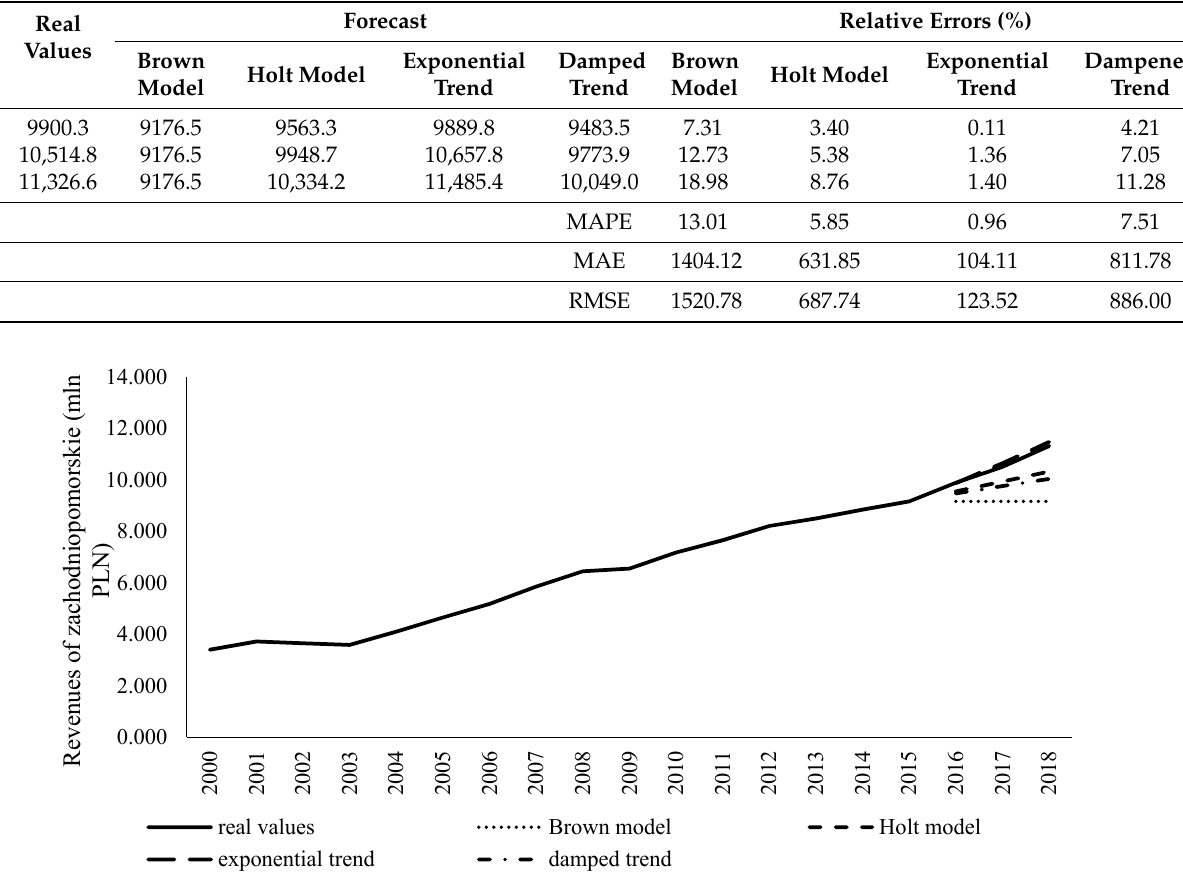
Figure 2. Real values (2000–2018) and forecasts (2016–2018) of revenue of Zachodniopomorskie voivodeship (exponential smoothing models).